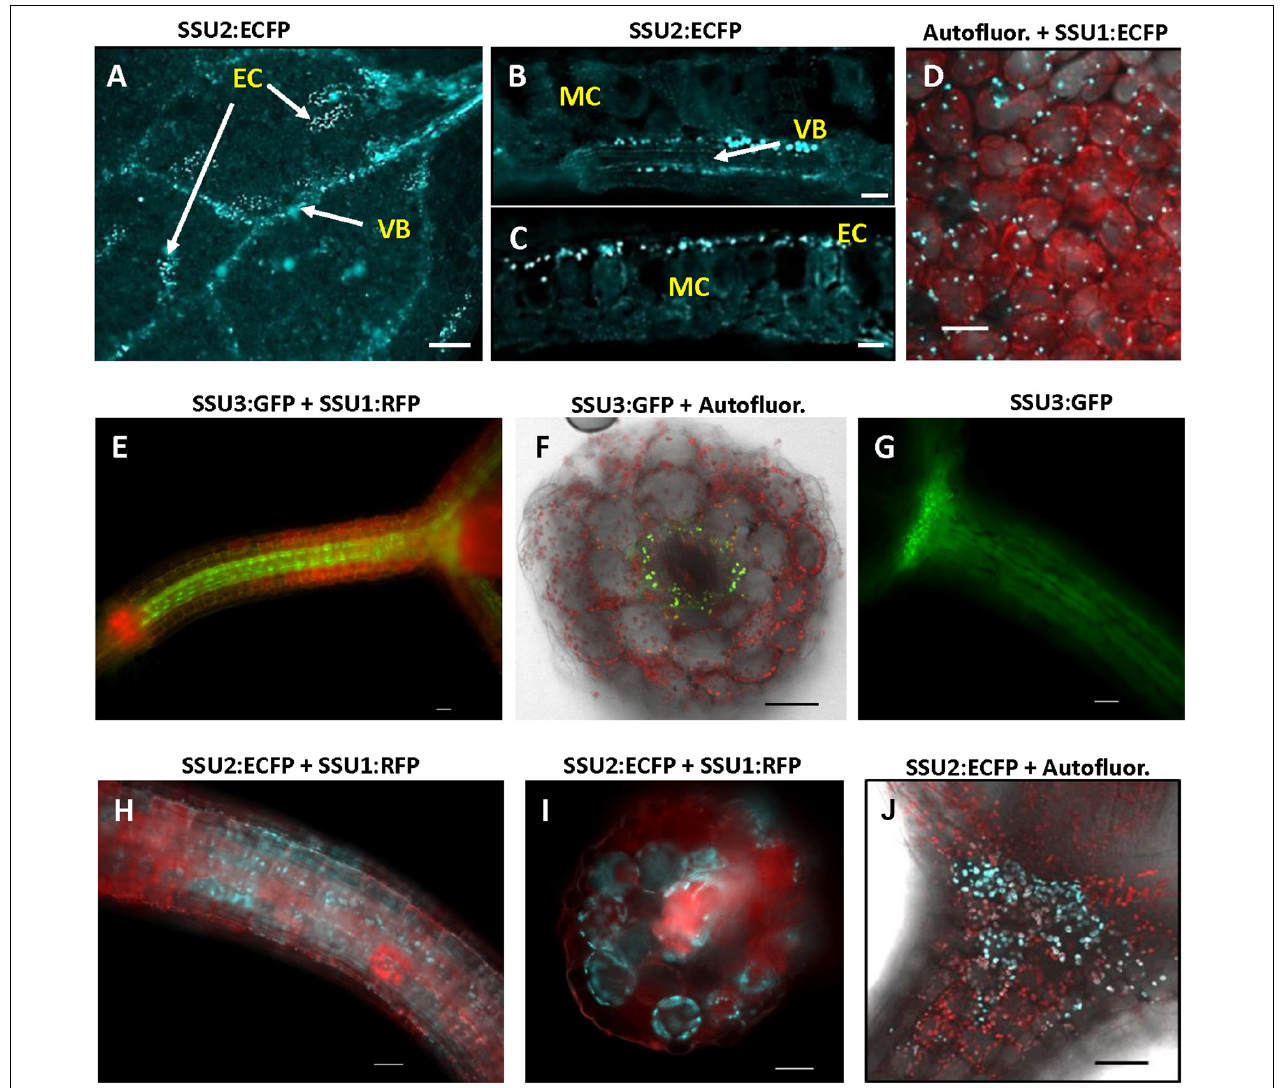
FIGURE 3 | Localization of the small subunits of IPMI in different parts of young seedlings. (A–D) cotyledons, (E–J) hypocotyls. Whole mount (A) and cross sections of cotyledons (B,C) . IPMI SSU2:ECFP (cyan) is seen in the cells along the vascular bundles (VB) in cotyledons (A,B) and in isolated epidermis cells [EC in (A,C) ]. MC indicates mesophyll cells. (D) View onto a leaf indicating that the fluorescence of IPMI SSU1:ECFP (cyan) is mainly detected in plastids with a longitudinal diameter of approximately 4–5 µ m in the epidermis. (E–J) IPMI SSU1-3 expression in the hypocotyl. (D,F,H,J) Autofluor., chlorophyll autofluorescence (red). Scale bars correspond to 20 µ m (B,C) , 50 µ m (A,D–J)